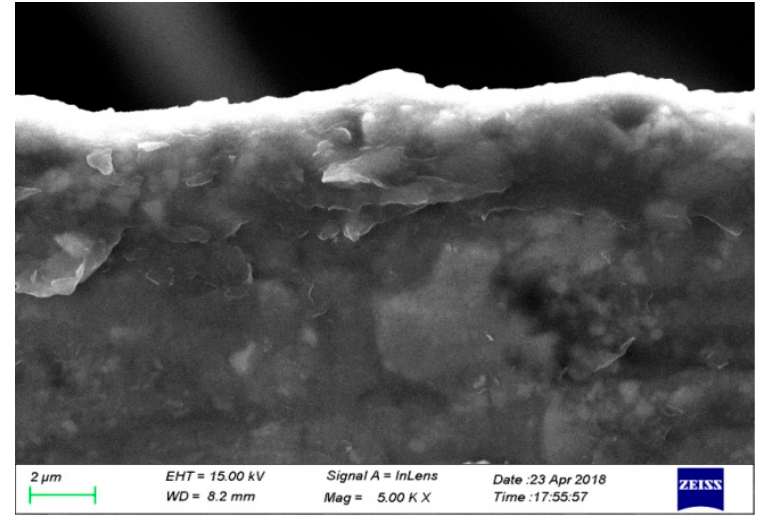
Figure 8. Section topography of the DLC film.